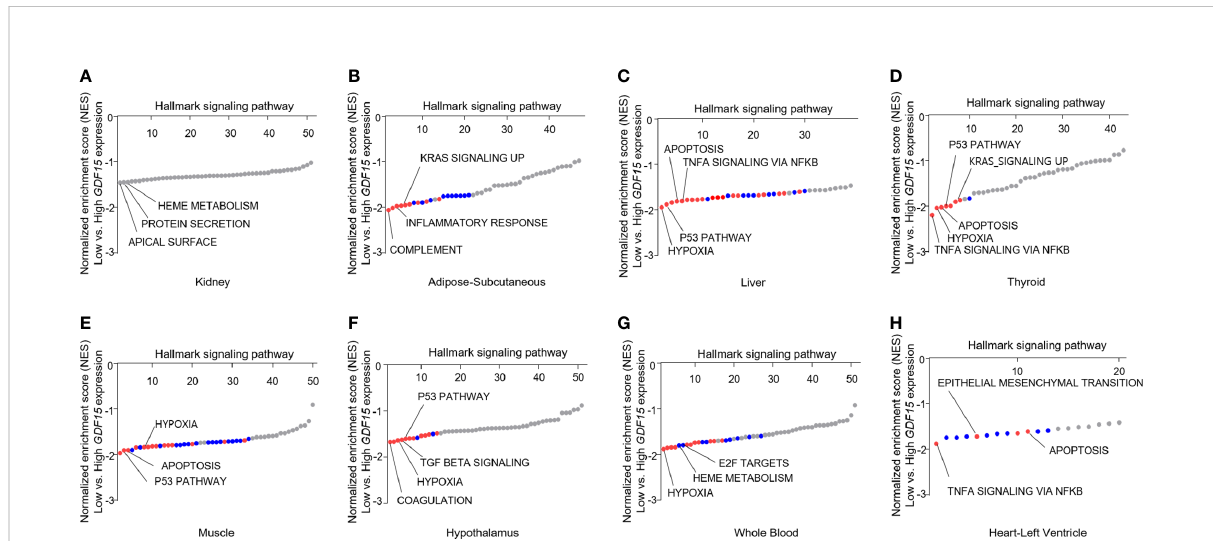
FIGURE 1 Functional analysis of gene expression data according to GDF15 expression. Representative results of gene set enrichment analysis (GSEA) using gene ontology “ biological process ” enrichment terms in tissues according to GDF15 expression (low vs. high GDF15 expression groups) for (A) kidney (n = 21 for each group), (B) adipose-subcutaneous (n = 165 for each group), (C) liver (n = 56 for each group), (D) thyroid (n = 163 for each group), (E) skeletal muscle (n = 200 for each group), (F) hypothalamus (n = 24 each group), (G) whole blood (n = 188 for each group), and (H) heart-left ventricle (n = 107 each group). Representative gene sets are indicated by gene set names. Red circles indicate signi fi cant gene sets (nominal P value ≤ 0.0001 and false discovery rate (FDR) q-value ≤ 0.25). Blue circles indicate gene sets with high FDR q-values although the P value is meaningful (nominal p-value ≤ 0.01 and FDR q-value >